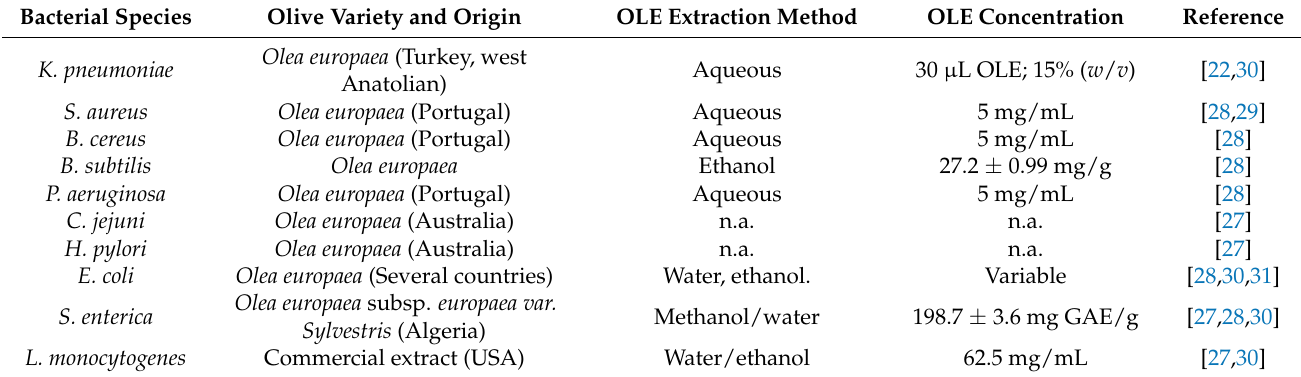
Table 1. Bacterial growth inhibition studies with olive leaf extract (OLE) treatment on bacteria